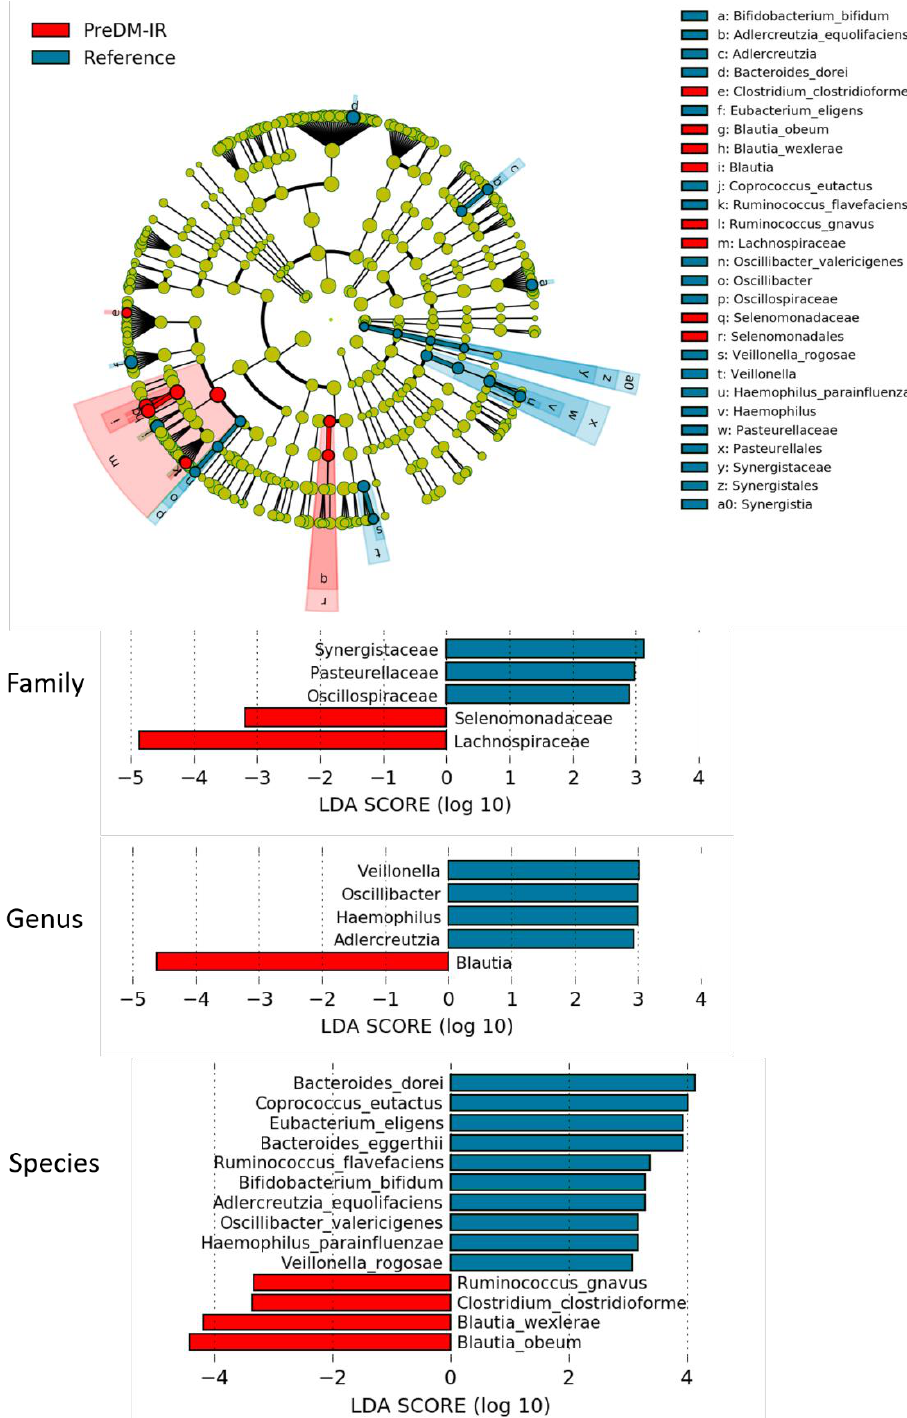
Figure 3. Gut microbiome composition in the PreDM-IR group relative to the Reference group. Linear discriminant analysis (LDA) score (log10) above 2.0 and p < 0.05.